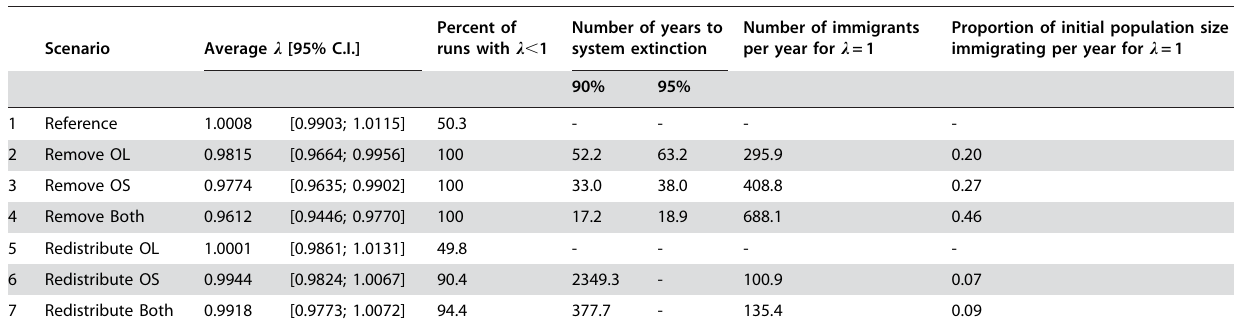
Table 3. Average and confidence intervals for l , the percentage of runs with l , 1, and the number of years to extinction for two probability levels (see Figure 4) based on 1000 parametric bootstrap samples for the seven scenarios (reference matrix and the